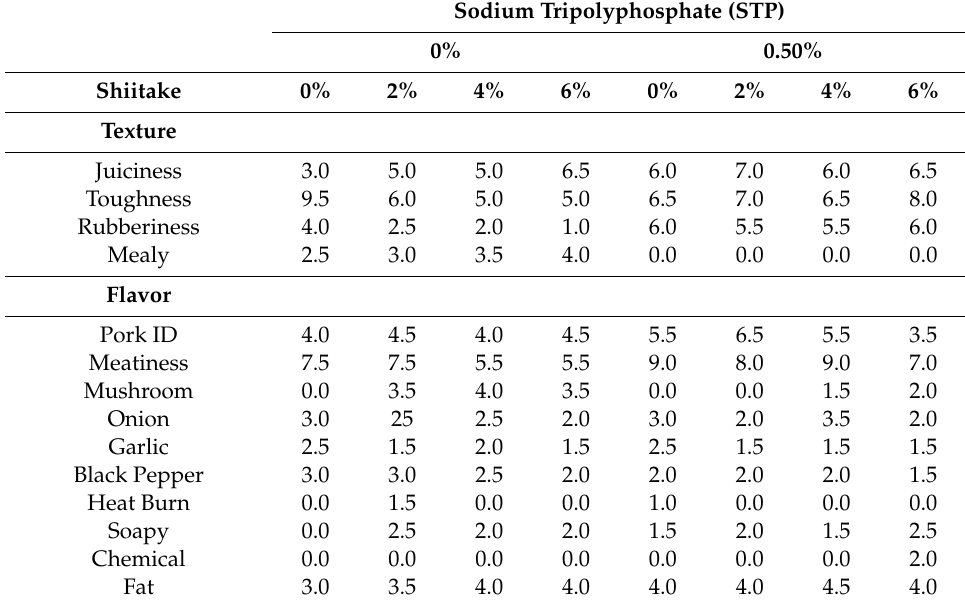
Table 5. Flavor and texture profile scores for pork patties with varied percentages of shiitake mushroom powder with and without phosphate, and with 96 h